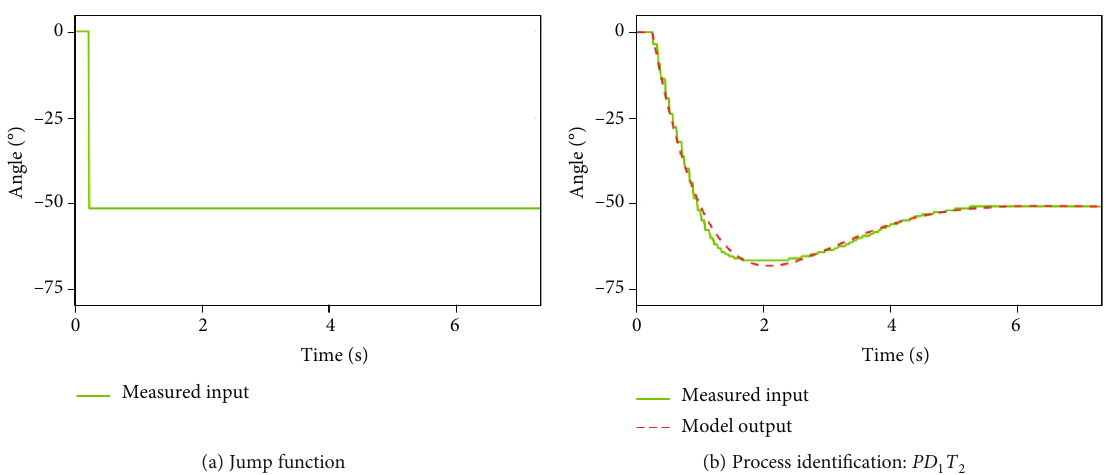
Figure 4: Process identi fi cation of the longitudinal axis. (a) shows the stimulation of the process, and (b) con fi rms the measured output and the process